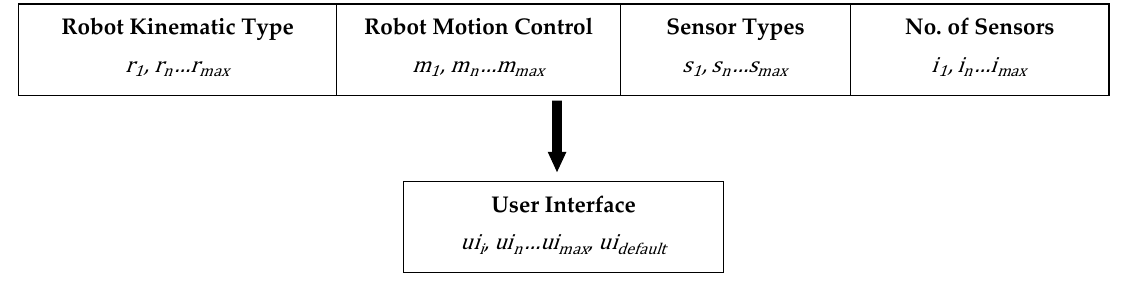
Figure 5. Matlab toolbox input and output formats.